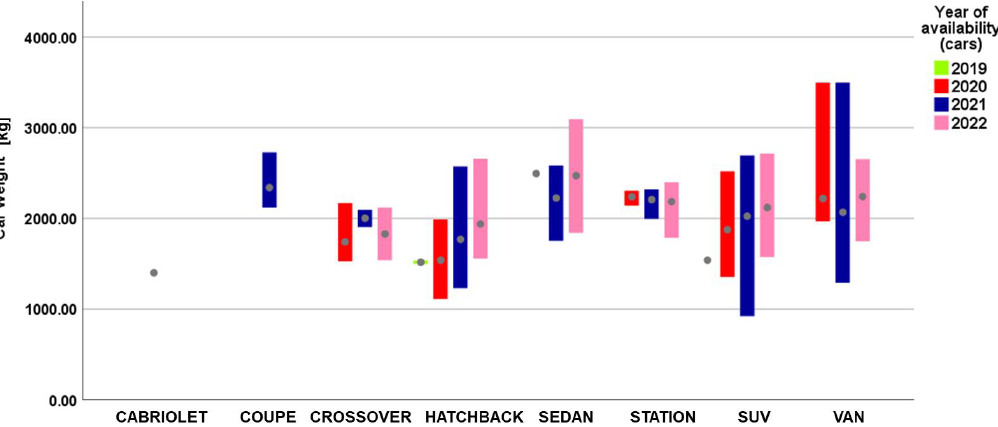
Figure 19. Range bar variation (min, max, mean) representation of vehicle weight vs. type of cars.